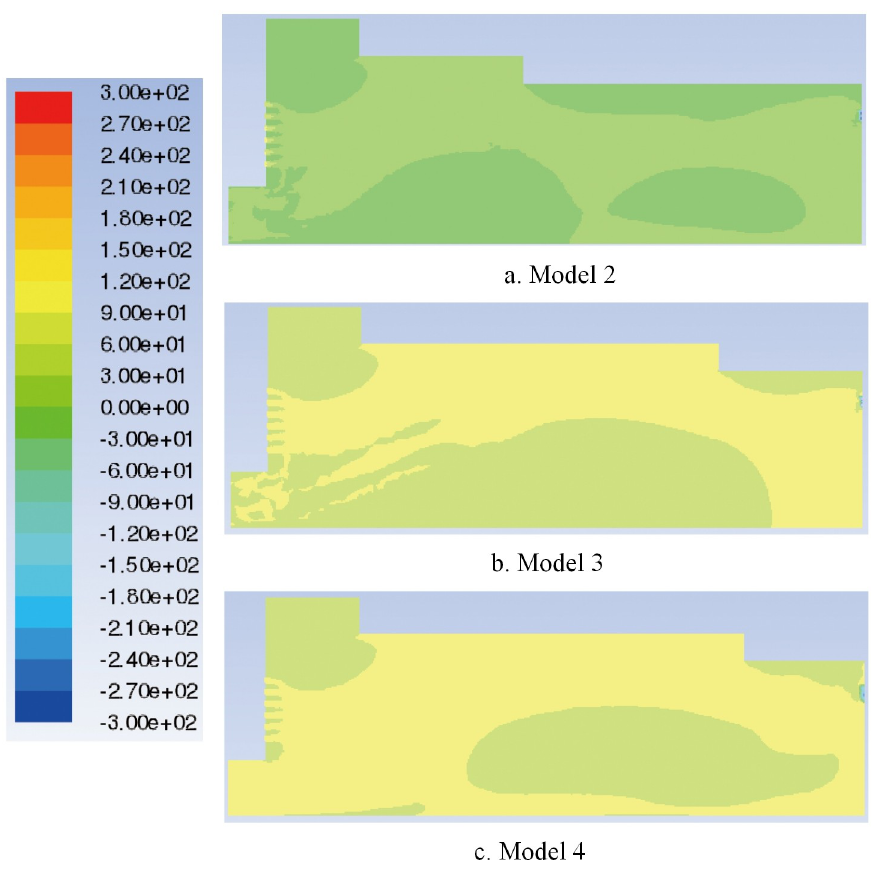
Fig 15. Flow field total pressure distribution of different paver